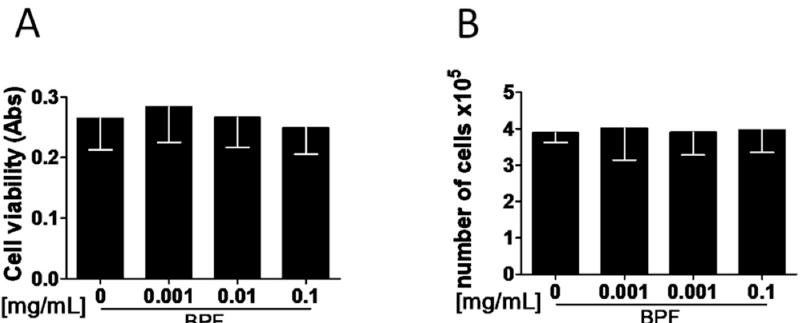
Figure 1. BPF does not increase viability and cell proliferation of Saos-2 cells. Semi-confluent cultures of human osteoblast-like cells (Saos-2) incubated with BPF 0.001-0.01-0.1 mg/mL for 24 h. ( A ) Cell viability determined by MTT assay. ( B ) Cell proliferation determined by counting the number of cells in each well. Data are represented as mean ± SD. Abbreviations: BPF, Bergamot Polyphenol fraction; MTT assay, 3-(4,5-dimethylthiazol-2-yl)-2,5-diphenyltetrazolium bromide assay.